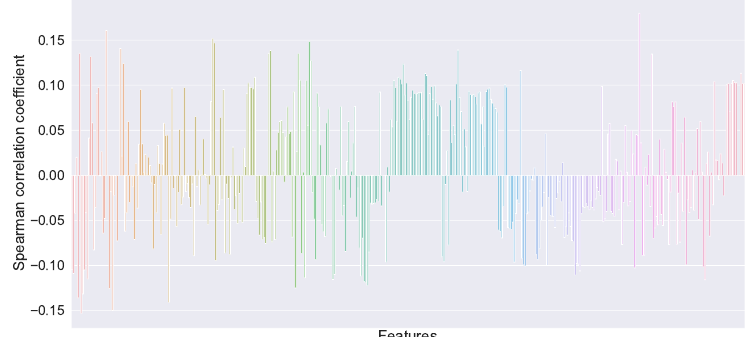
Figure 10. Spearman correlation coefficient between raw variables and FeO.